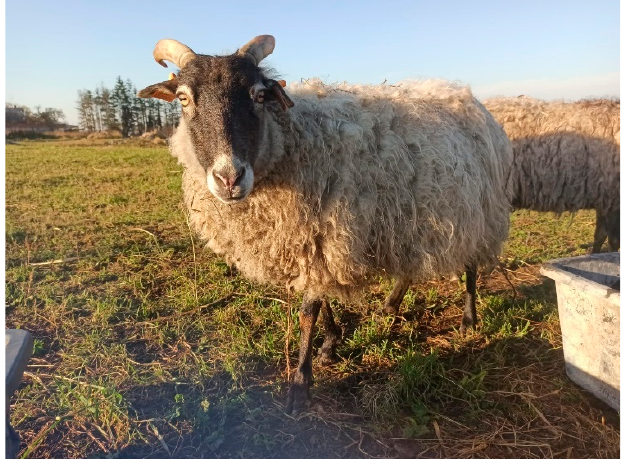
Figure 2. Wrzosówka sheep.